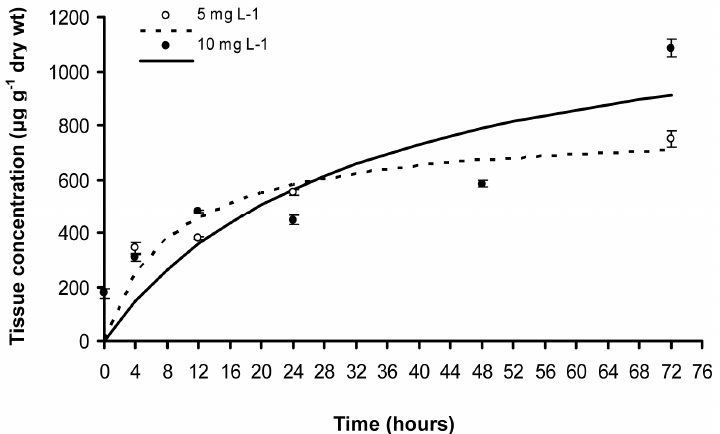
Figure 4. Kinetics of zinc uptake ( µ g g − 1 dry weight) in C. nodosa leaf blades at 5 mg L − 1 and 10 mg L − 1 ZnO NPs ± SD (n = 3); dashed and bold lines are the uptake kinetics calculated using Michaelis-Menten